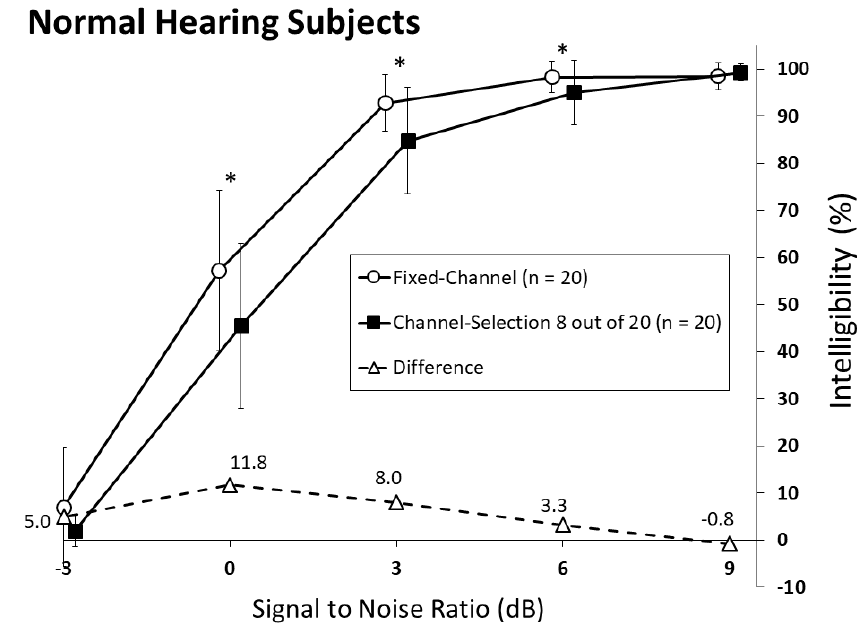
Figure 3. Syllable recognition function of the signal-to-noise ratio by NH subjects with the CI simulator using both strategies. Bars indicate the standard deviation. The asterisks indicate the significant differences (5% threshold). Table 2. Percentage comparisons for normal-hearing subjects between the simulation strategies.